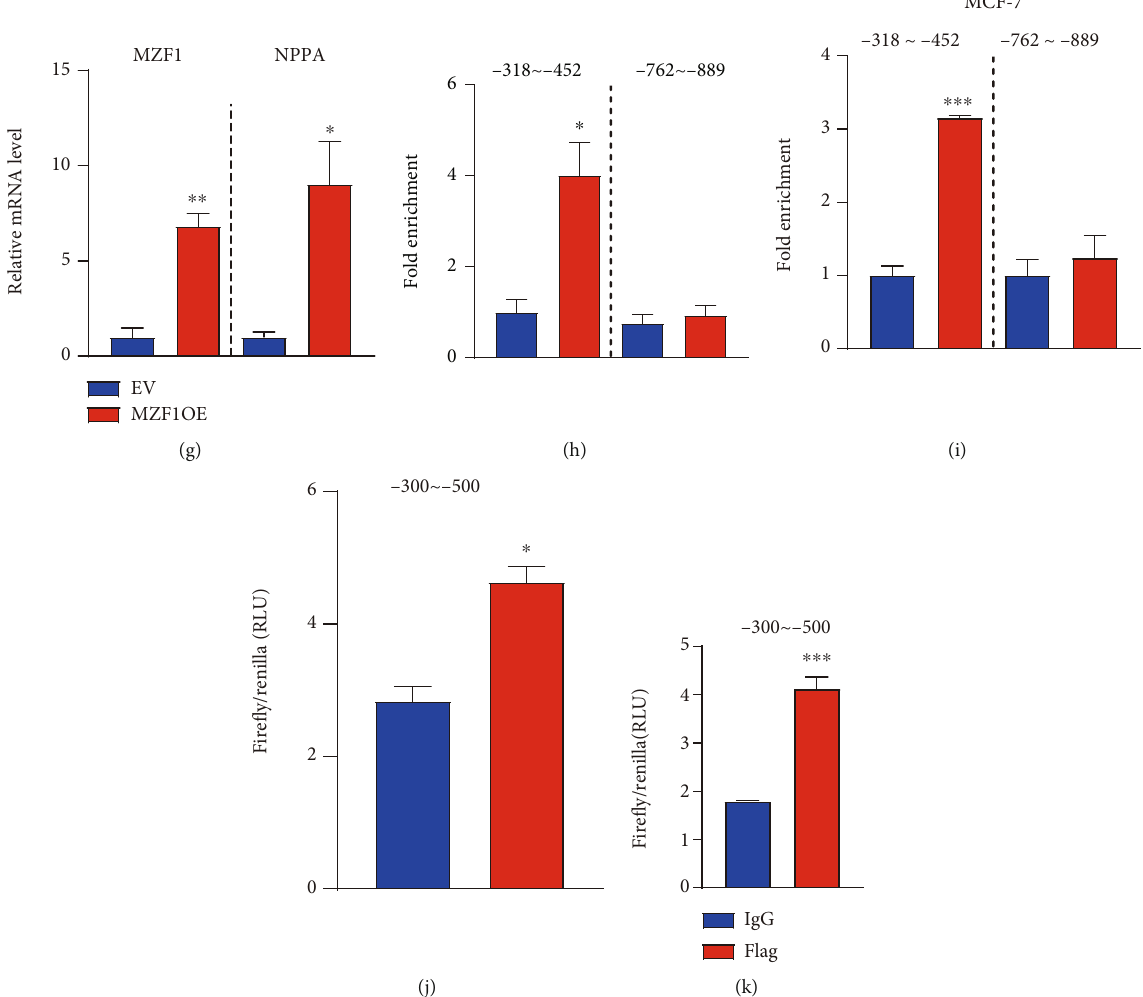
Figure 5: NPPA was transcriptionally modulated by MZF1 in breast cancer cells. (a) Veen plot showing the mutual transcription factors identi fi ed by both PROMO and JASPAR. (b) Dot plot showing the Pearson correlation between mRNA level of NPPA and 11 transcription factors. MZF1 was labeled in red. (c) Dot plot showing the correlation between NPPA and MZF1 mRNA levels in breast cancer patient. (d) The binding motif of MZF1. (e) The binding site of MZF1 to the promoter region of NPPA with PROMO and JASPAR. Binding sites in PROMO and JASPAR were labeled in red and blue, respectively. (f, g) Quanti fi cation of MZF1 and NPPA mRNA in MZF1 overexpressed MCF-7 (f) and MDA-MB-231 (g) cells. (h, i) ChIP result showing the binding of MZF1 to the -381 ~ - 452bp of the NPPA promoter region in MZF1 overexpressed MCF-7 (h) and MDA-MB-231 (i) cells. (j, k) Dual luciferase assay showing the relative transcription activity of -300 ~ -500 bp (Fire fl y/Renilla, RLU) in MZF1 overexpressed MCF-7 (j) and MDA-MB-231 (k) cells. Data are represented as mean ± SEM ; ∗ p < 0 : 05 , ∗∗ p < 0 : 01 , and ∗∗∗ p < 0 : 001 . The data were analyzed using Student ’ s t